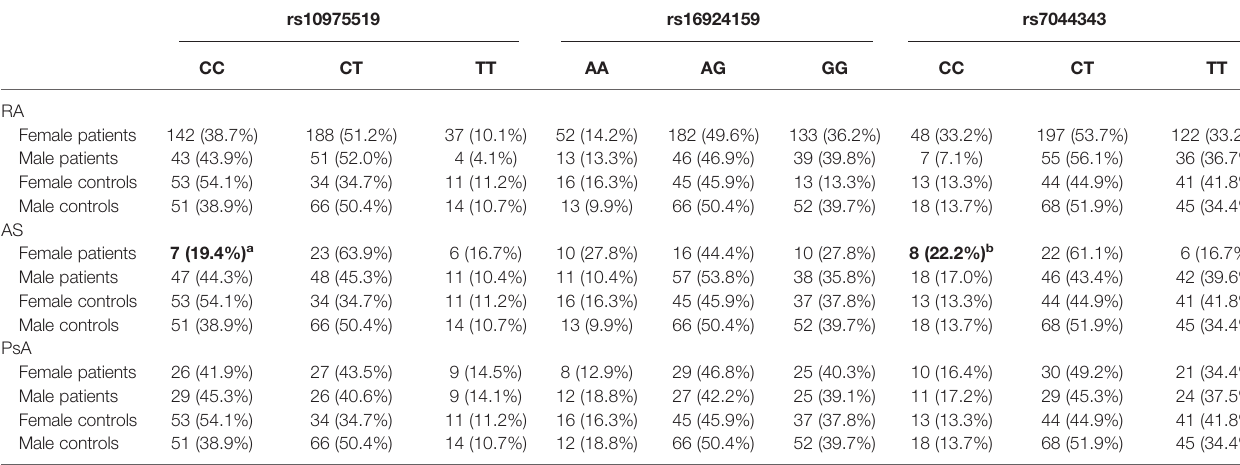
TABLE 2 | Gender-strati fi ed analysis of the IL-33 genotypes frequencies in rheumatoid arthritis, ankylosing spondylitis, and psoriatic arthritis patients.